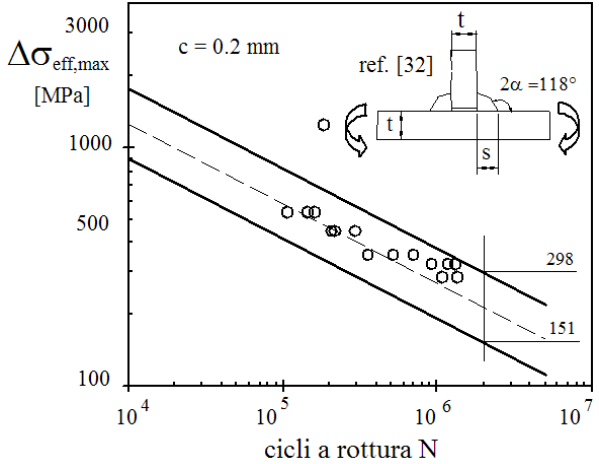
Figura 6: Previsione della resistenza a fatica calcolata per via completamente numerica di